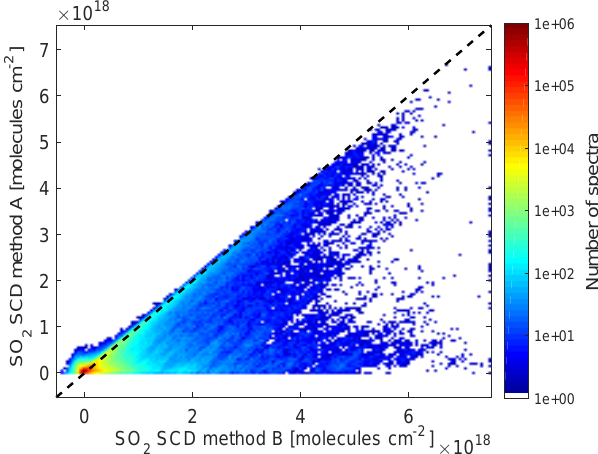
Figure 9. Two-dimensional histogram of the SO 2 SCDs from Method B vs. the SCDs from Method A for instrument D2J2201 at Nevado del Ruiz. Method B, which uses a modelled background spectrum, leads to larger SO 2 column densities. The black-dashed line shows the identity